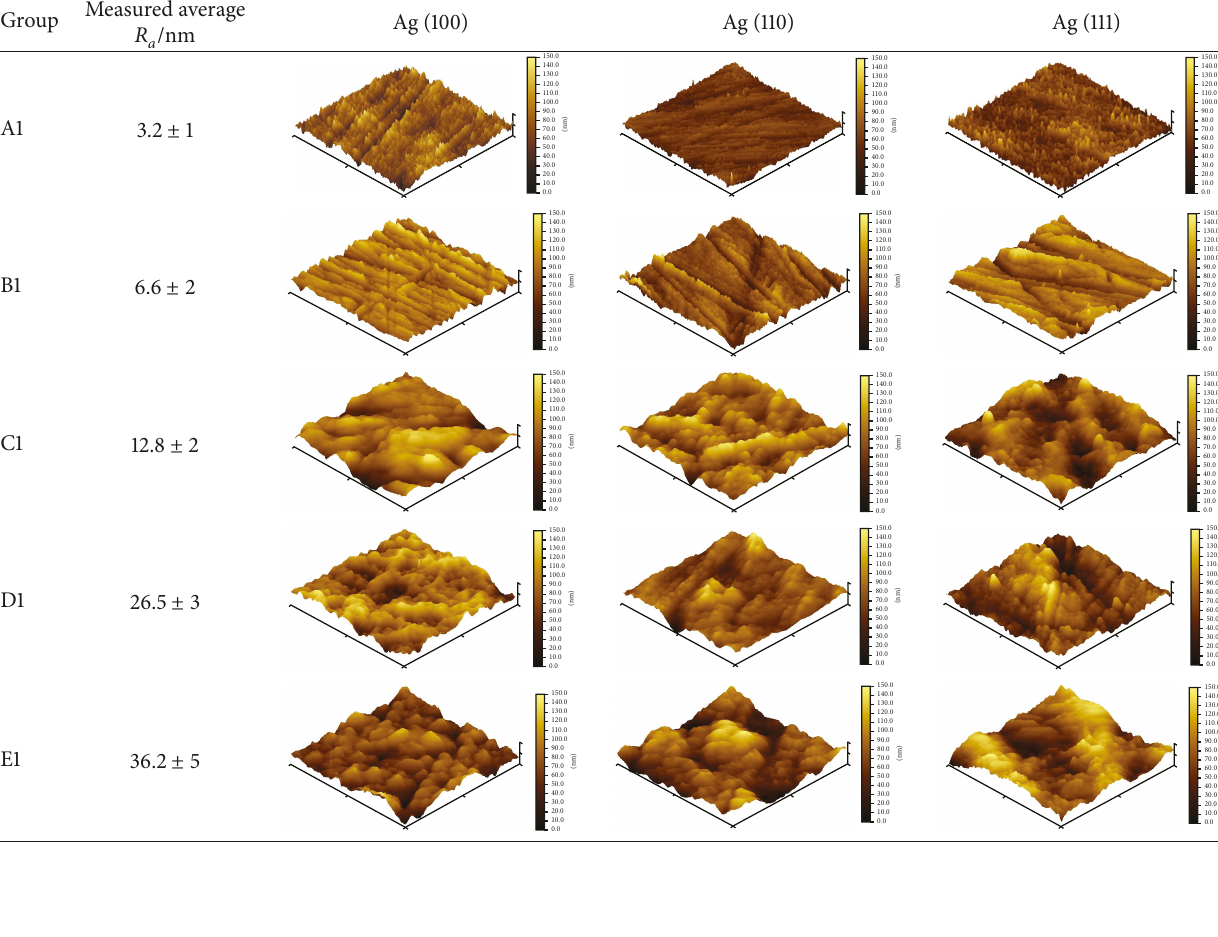
Table 1: The surface roughness of Ag (100), Ag (110), and Ag (111) crystals was quantitatively categorized into five different groups, that is, (A1) 𝑅 𝑎 = 0.00–5.00 nm; (B1) 𝑅 𝑎 = 5.01–10.00 nm; (C1) 𝑅 𝑎 = 10.01–20.00 nm; (D1) 𝑅 𝑎 = 20.01–30.00 nm; and (E1) 𝑅 𝑎 = 30.01–45.00 nm. Their average 𝑅 𝑎 were determined from the AFM analysis.